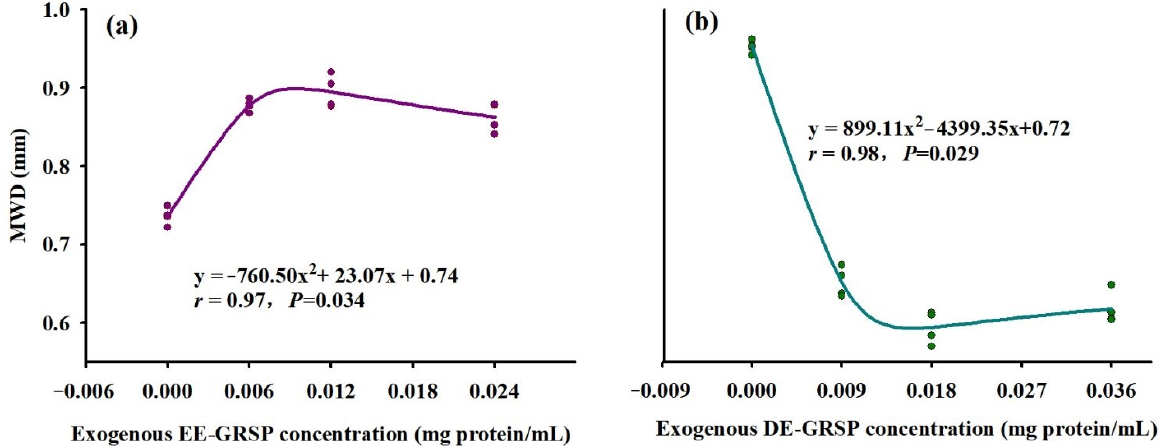
Figure 2. Correlation between exogenous EE-GRSP ( a ) and exogenous DE-GRSP ( b ) and the soil mean weight diameter ( n = 16).